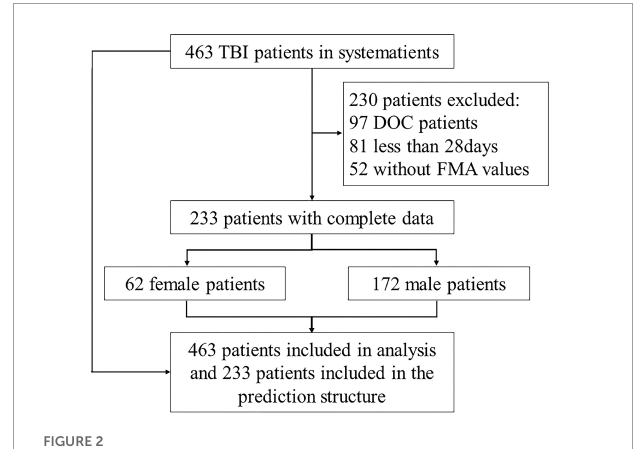
FIGURE2 Research data source and population. DOC, disturbance of